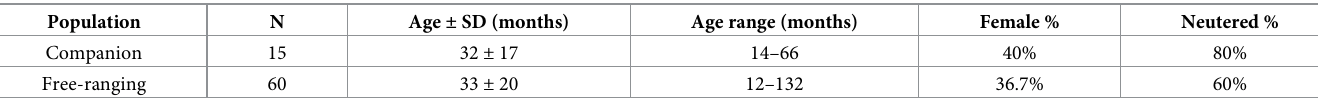
Table 1. Demographic data of the adult ( > 1-year-old) companion and free-ranging dog population. Population N Companion